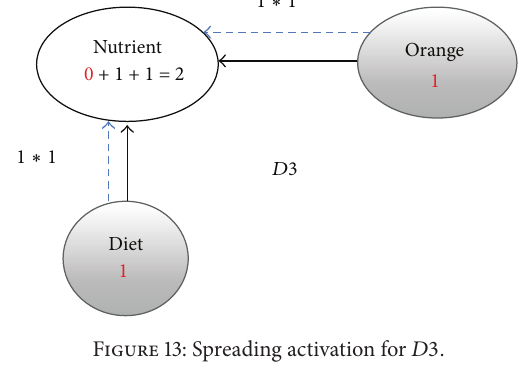
Figure 13: Spreading activation for 𝐷3 .